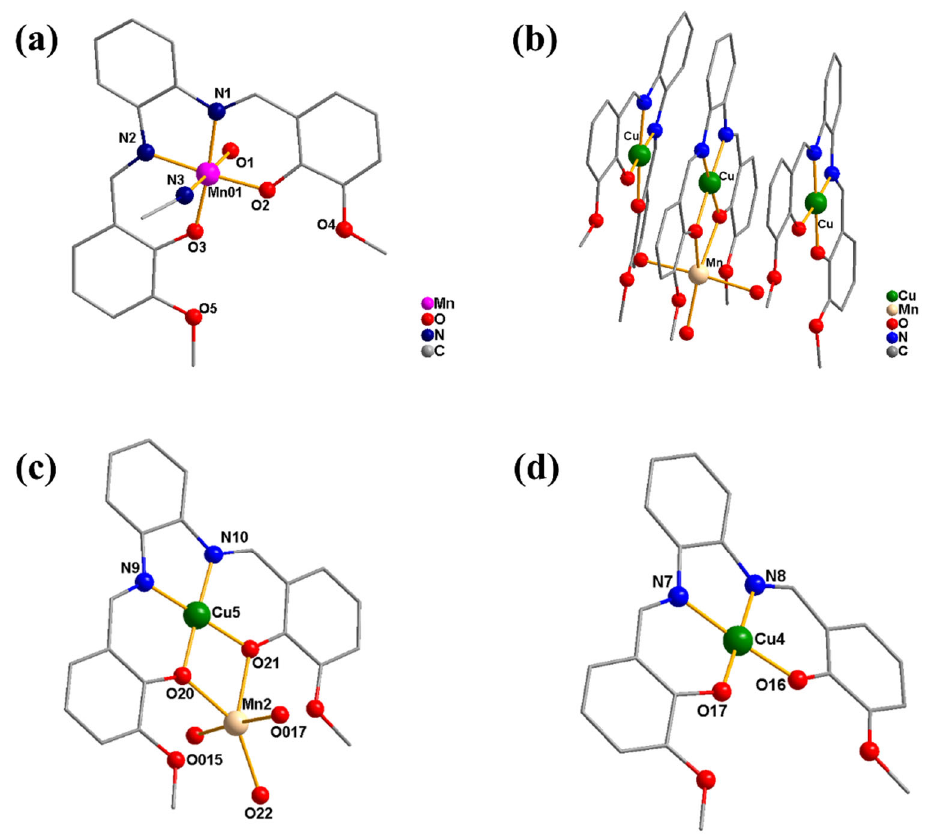
Figure 1. Crystal structures of complex 1 ( a ) and 2 (( b ): the whole part of 2 ; ( c ): the middle Mn–Cu cation moiety in 2 ; ( d ): the natural Cu moiety in 2 ) (hydrogen atoms, solvents, and anions have been omitted for clarity).